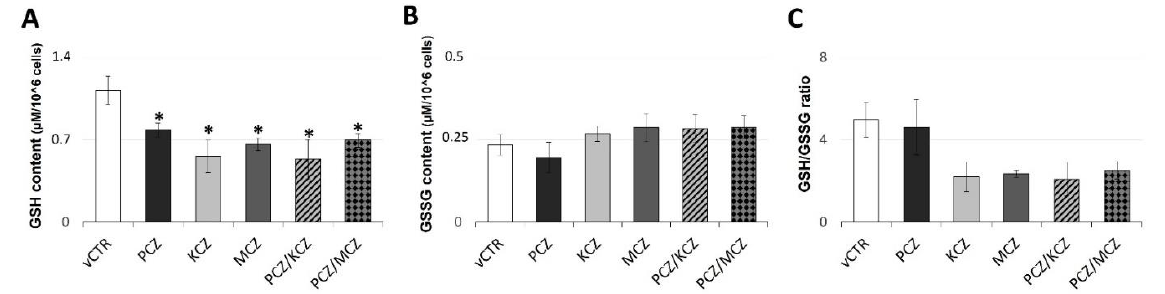
Figure 8. Azoles induced marked depletion of GSH reservoir with further underlying loss in GSH/GSSG ratio. Levels of ( A ) reduced (GSH), ( B ) oxidised (GSSG) glutathione, and ( C ) GSH/GSSG ratio in vCTR and azoles-treated groups after 3 h of incubation. Values from three independent experiments are expressed as medians ± SE; one-way ANOVA, followed by Holm – Sidak test; * p < 0.05 vs. vCTR.